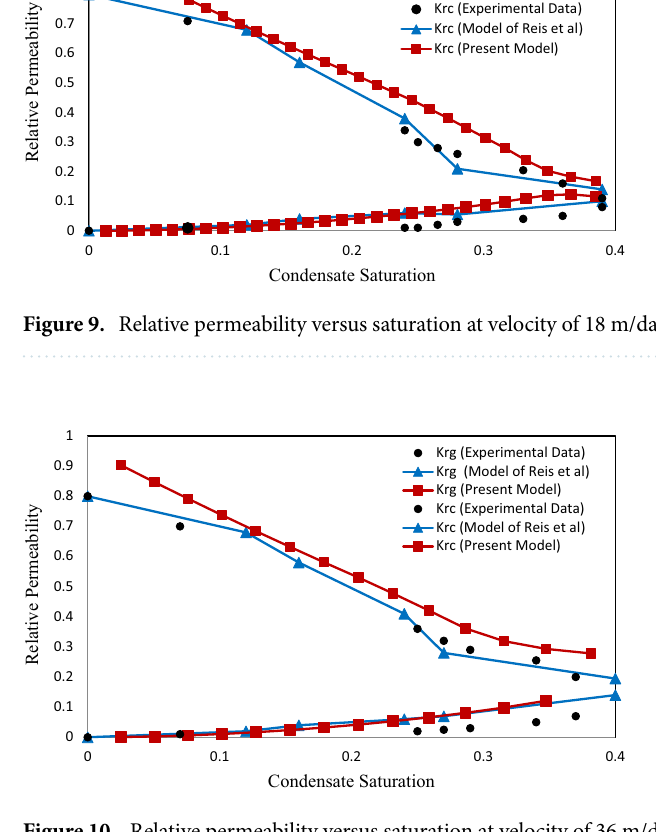
Figure 10. Relative permeability versus saturation at velocity of 36 m/day and IFT = 0.037 mN/m.